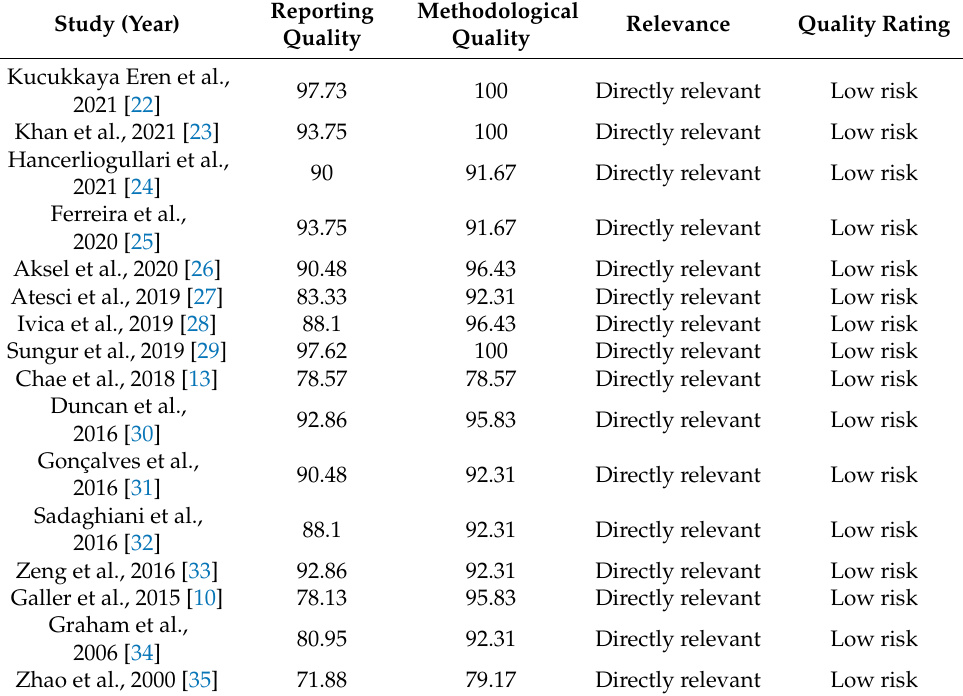
Table 3. Final results of the quality assessment of the included studies, according to the SciRAP